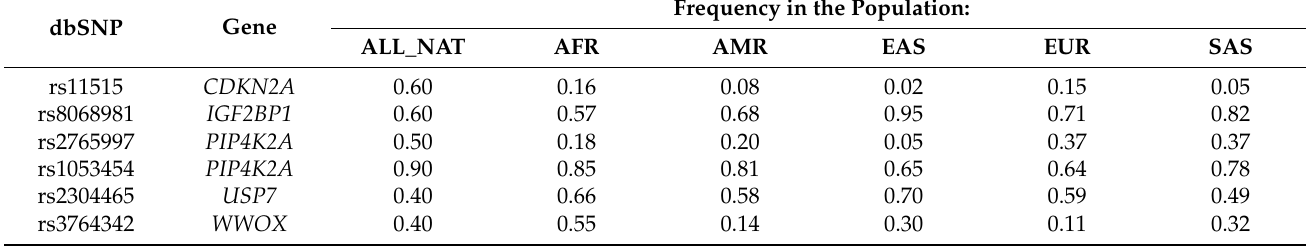
Table 3. Allele frequencies of the six key variants identified in the present study in the ALL_NAT populations (Table 2) and the five continental populations from the 1000 Genomes Project (AFR, AMR, EAS, EUR, and